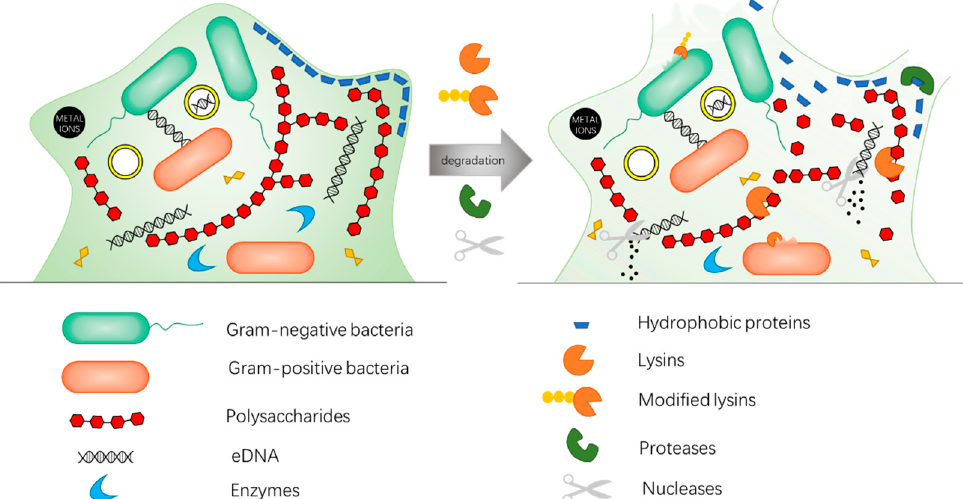
Figure 3. Mechanisms of enzybiotics eradicating bacterial biofilm. The biofilm consists of a combination of glycoproteins, carbohydrates, lipids, eDNA, and bacterial cell. When treating with enzybiotics, different enzymes bind to their respective targets for degradation. In this figure, lysins, proteases and nucleases bind to polysaccharides, proteins and eDNA in the biofilm and degrade them, respectively, thus promoting the disintegration of the biofilm. Besides, lysins also decompose the peptidoglycan, one of the important components of bacteria cell walls, to kill bacteria, especially for Gram-positive species. The peptidoglycan of Gram-negative bacteria is difficult to degrade due to the protection of the outer membrane, while modified lysins may take effect.